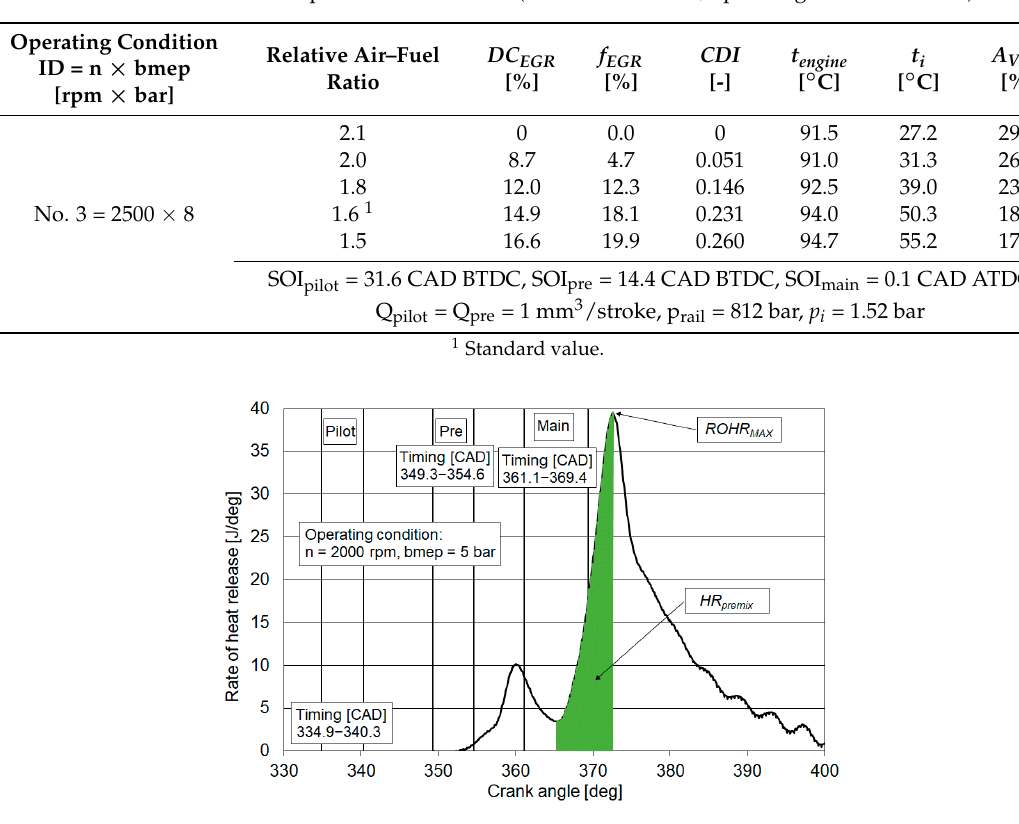
Figure 3. Example of rate of heat release curve and related combustion parameters.